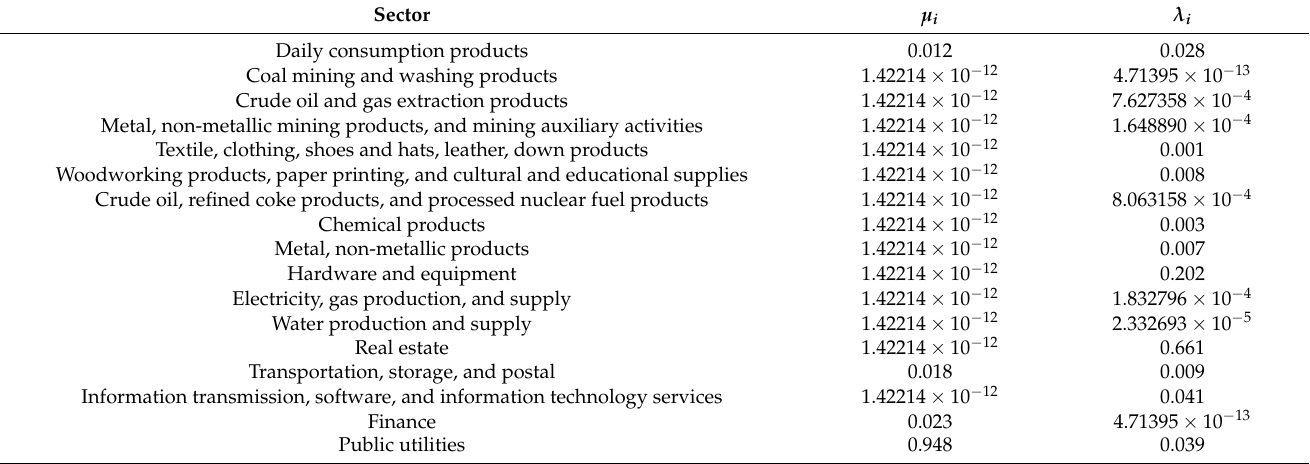
Table A9. The results of calibration of µ i and λ i .